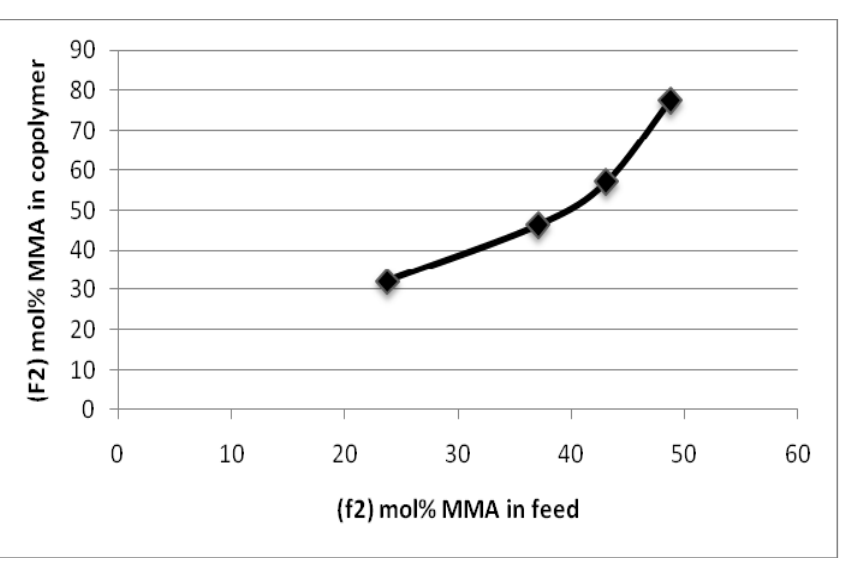
Figure 11. Mol percents of MMA in copolymer vs. in monomer